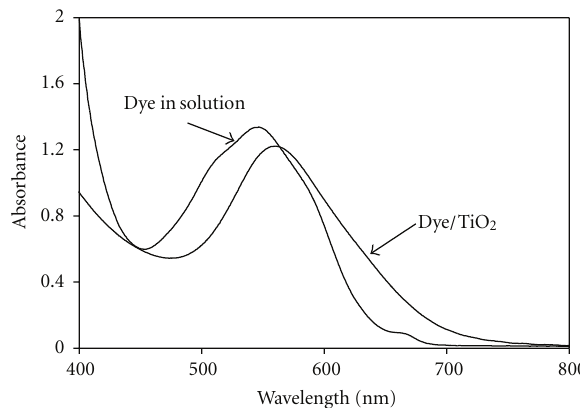
Figure 6: The absorption spectra of anthocyanin extracted from red